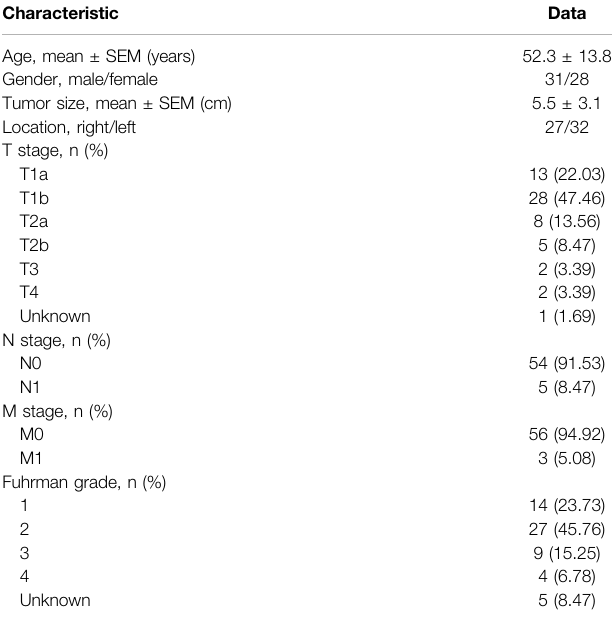
TABLE 1 | Clinical characteristics of 59 patients with renal cell carcinoma.